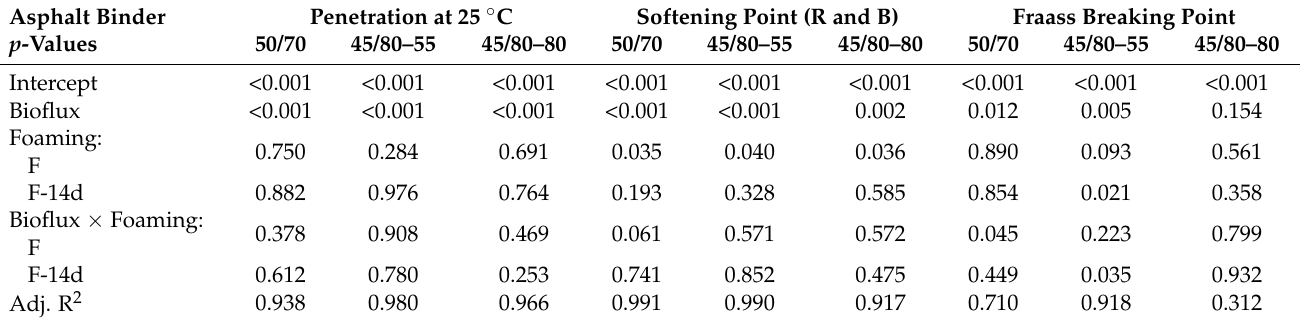
Table 3. The p -values calculated in analyses of variance for assessing the significance of the effects of Bioflux and foaming on the classical parameters of asphalt binders.